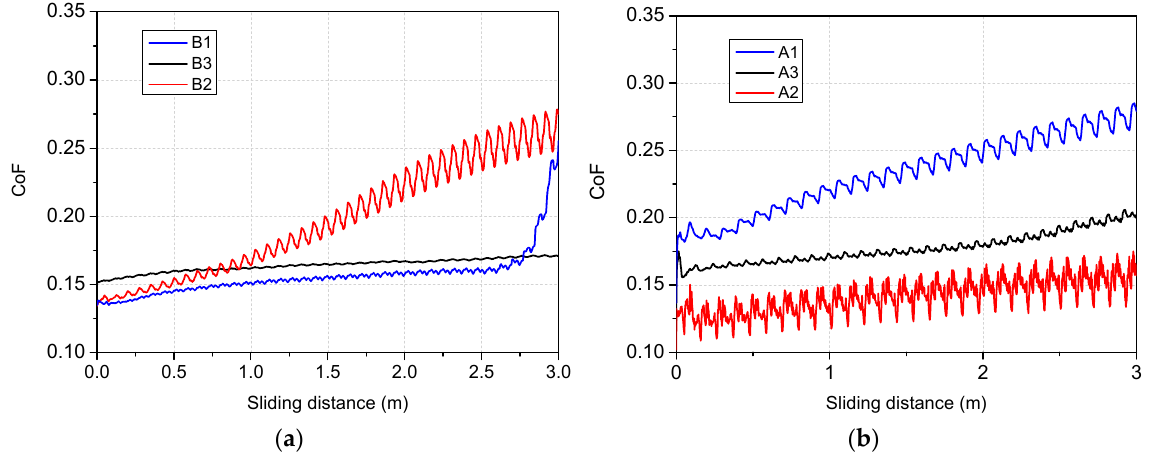
Figure 9. The variation of the friction coefficient as function of wear distance: ( a ) SiO 2 and ( b ) Cr 2 O 3 configurations.